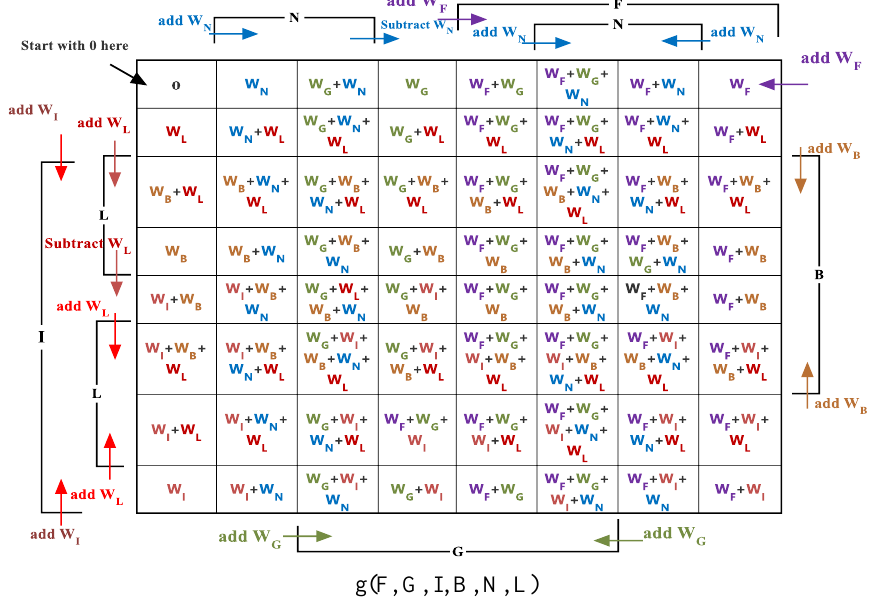
Fig. 2. The pseudo-switching function g with symbolic entries representing sums of pertinent weights. Here, the half map labeled by a certain variable is called the asserted region of the variable, while the other half of the map is called its non-asserted